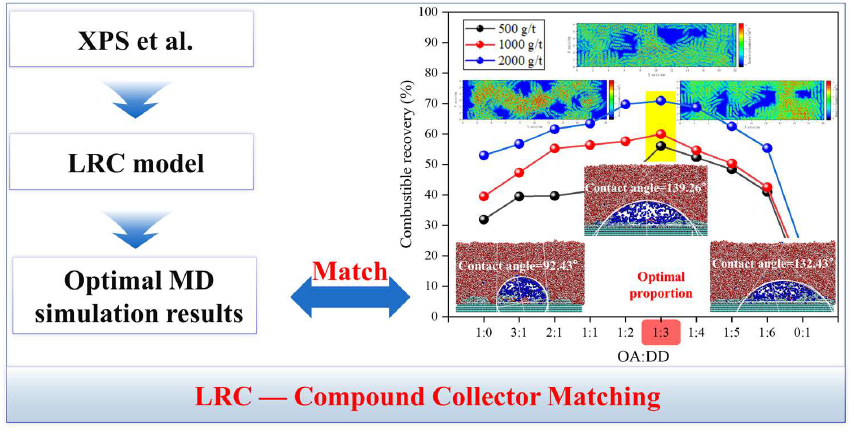
Figure 14. The schematic diagram of LRC–compound collector matching principle.